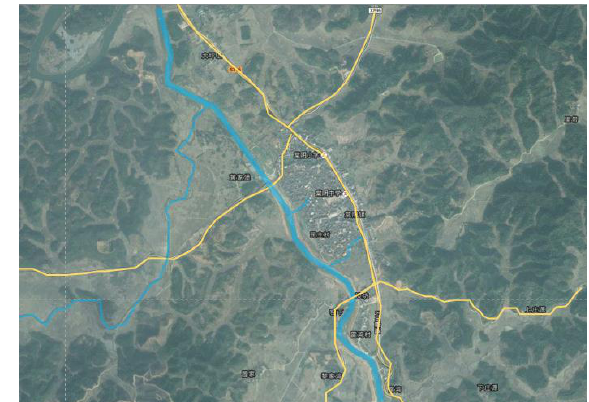
Figure1. Satellite Imagery of Tangyin Township (Picture source: self-drawing)